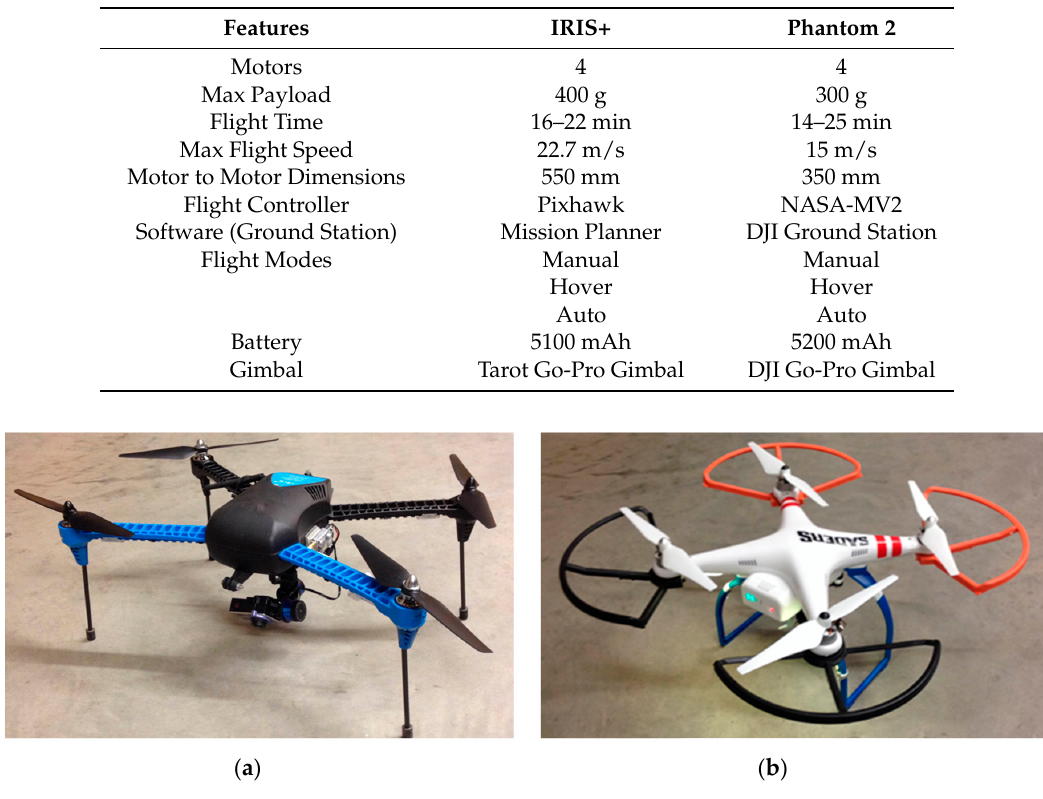
Table 1. Iris+ and Phantom 2 Specifications.